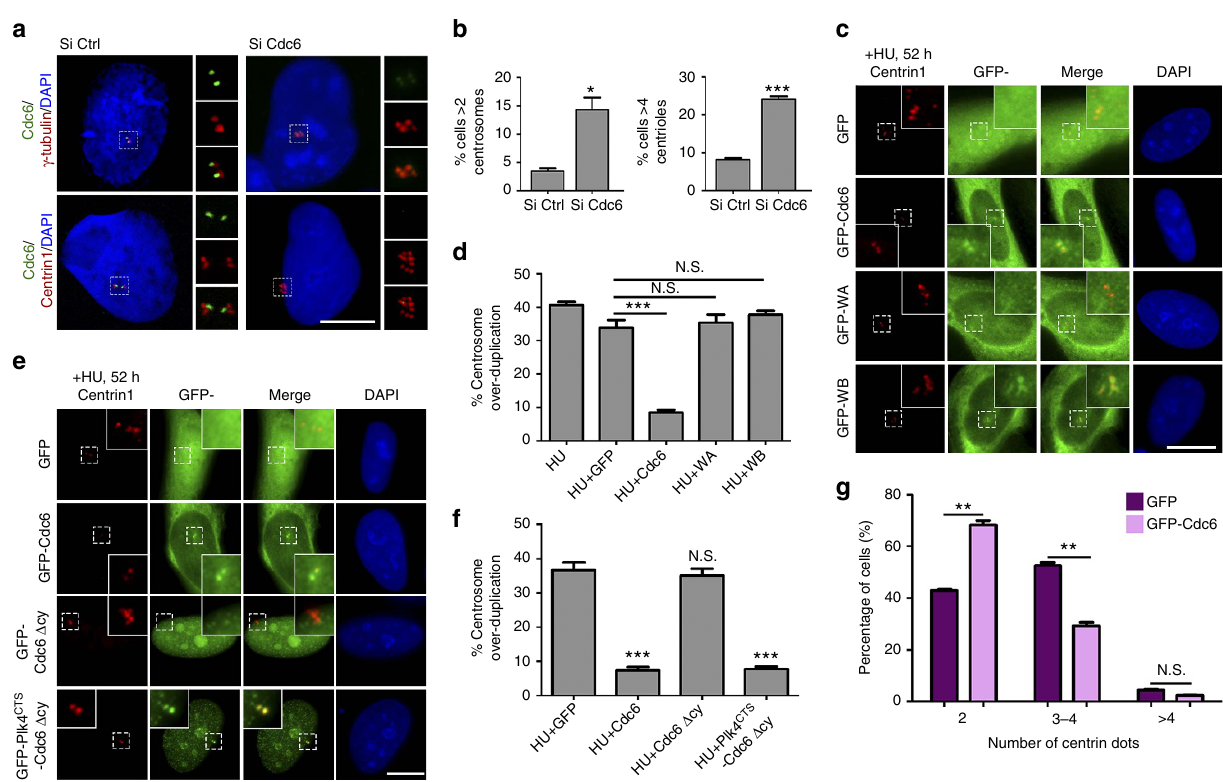
Figure 2 | Cdc6 negatively regulates centrosome duplication. ( a ) Cdc6 depletion induces centriole and centrosome over-duplication. Immunofluorescence of Cdc6 (green), centrin1 (red) and g -tubulin (red) in U2OS cells transfected with control or Cdc6 siRNA. ( b ) Quantitation of cells with 4 2 centrosomes or 4 4 centrioles in a . Approximately 300 cells were counted per sample, and three independent experiments were conducted. ( c ) Cdc6 WT, but not WA or WB mutant, inhibits HU-induced centrosome over-duplication. U2OS cells were transfected with GFP, GFP-Cdc6, GFP-WA or GFP-WB, and treated with 16mM HU for 52h to allow centriole amplification. The cells were then stained with a centrin1 antibody. ( d ) Quantitation of cells with 4 4 centrioles in c . Approximately 300 cells were counted per sample, and three independent experiments were conducted. ( e ) Centrosomal localization of Cdc6 is required for its inhibition on the HU-induced centrosome over-duplication. U2OS cells were transfected with GFP, GFP-tagged Cdc6, GFP-tagged Cdc6 D cy or GFP-tagged Plk4 CTS -Cdc6 D cy, and treated with 16mM HU for 52h to allow centriole amplification. The cells were then stained with a centrin 1 antibody. ( f ) Quantitation of cells with 4 4 centrioles in e . Approximately 100 cells were counted per sample, and three independent experiments were conducted. ( g ) Overexpression of Cdc6 inhibits centriole duplication during the normal cell cycle. U2OS cells were transiently transfected with GFP or GFP-tagged Cdc6 for 50h and stained with a centrin1 antibody. The number of centrin1-positive dots in transfected cells was counted. Approximately 300 cells were counted per sample, and three independent experiments were conducted. The statistical data in ( b , d , f , g ) are presented as means ± s.d. * P o 0.05, ** P o 0.01, and *** P o 0.001; N.S., no significant difference (Student’s t -test). DNA was stained with DAPI. Scale bars, 10 m m. Insets in a , c and e are high-magnification views of the regions indicated in the low-magnification